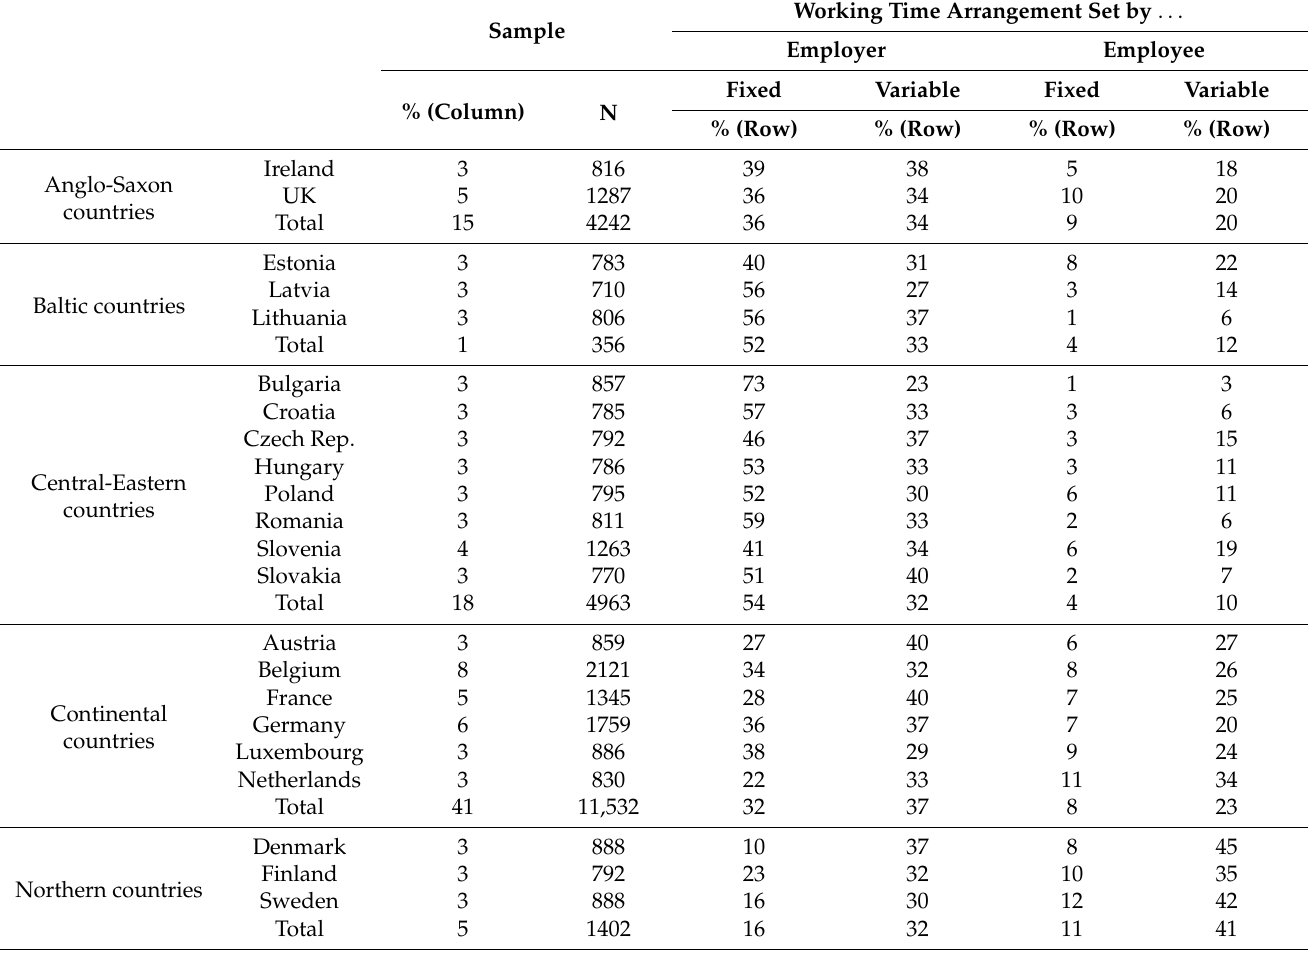
Table A1. Descriptive sample statistics for countries and country clusters